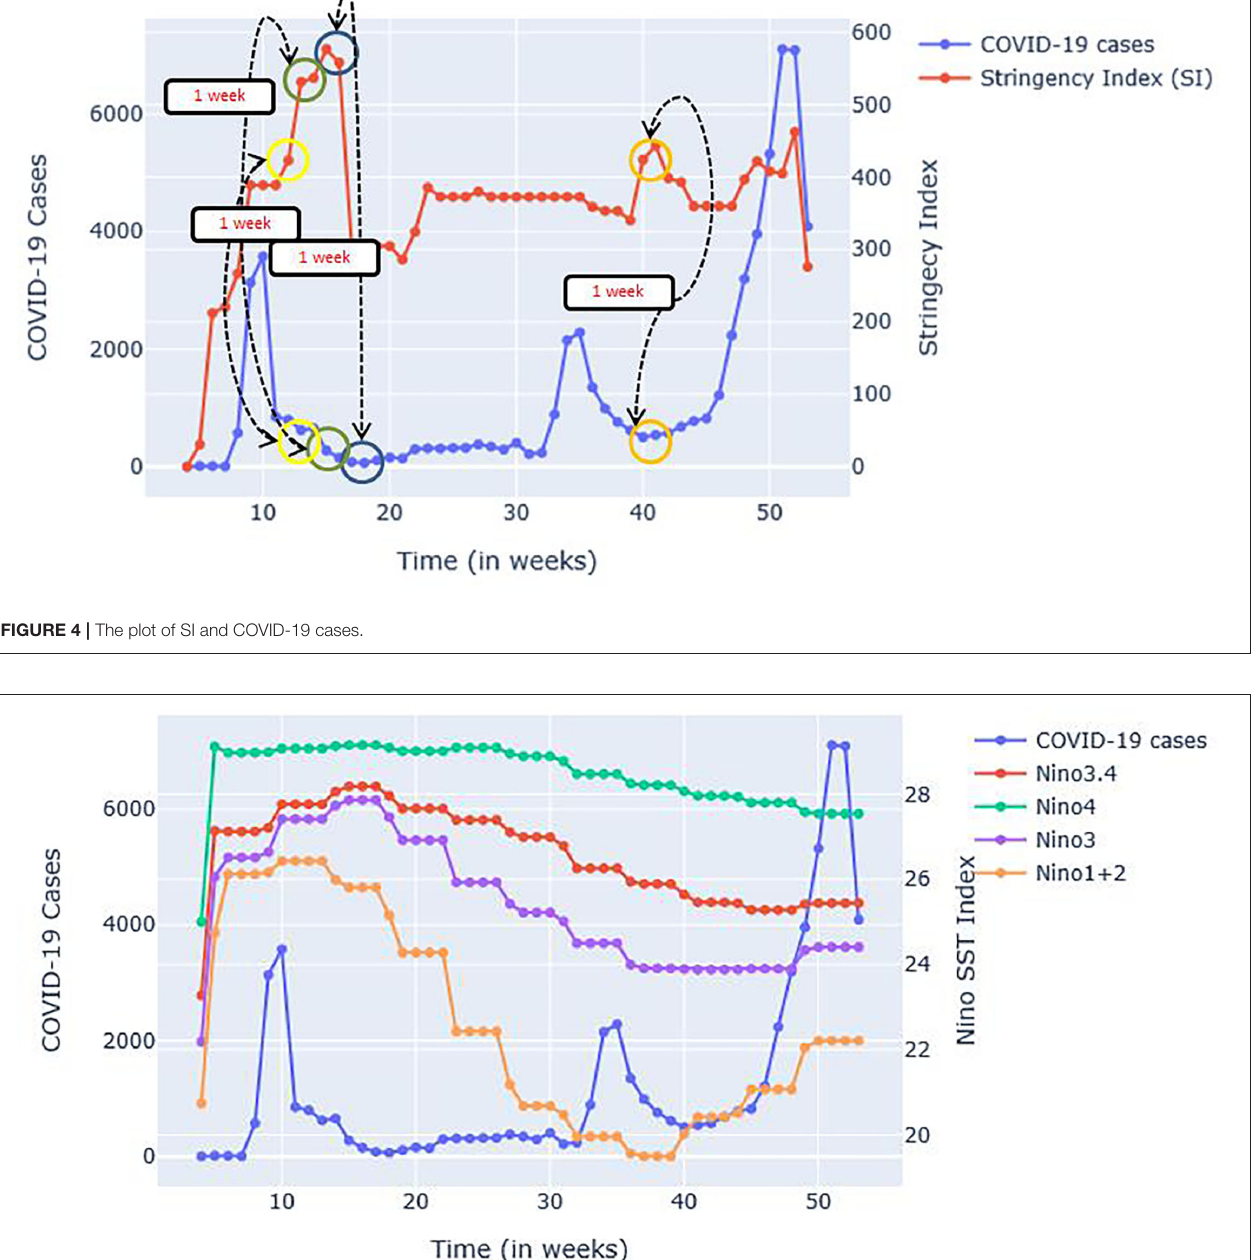
the performance indicators employed are shown in Table 3